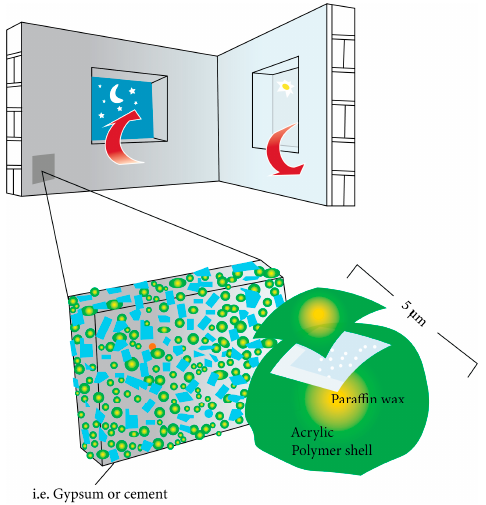
Figure 13. PCM capsules inside construction materials (adopted from [32]).